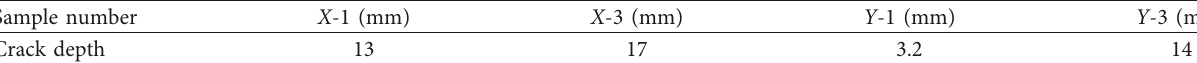
Table 4: The crack depth.